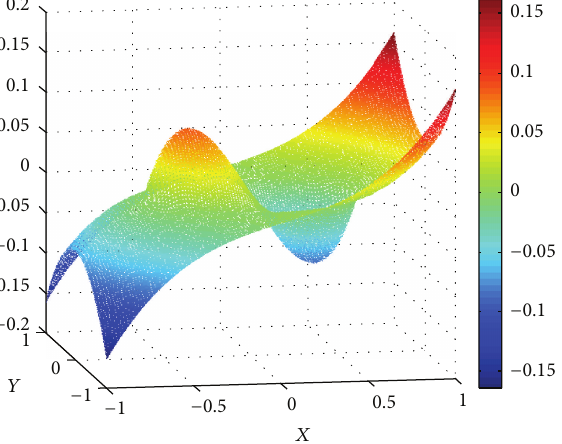
Figure 8: 𝑥 -component, 𝜇 − = 1, 𝜇 + = 100, 𝜆 = 5𝜇 elliptical